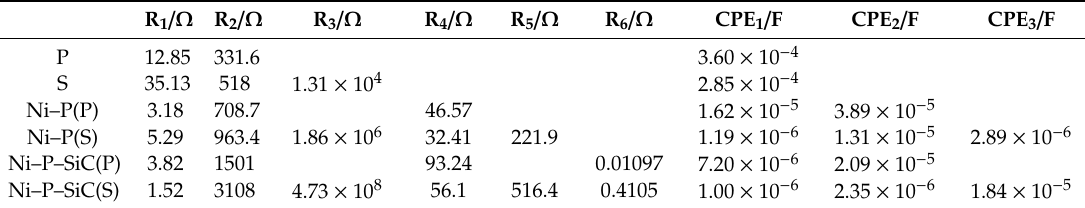
Figure 12. Equivalent circuit diagram of coatings prepared by scanning electrodeposition on 45 steel substrates with di ff erent pretreatment processes: ( a ) polishing, ( b ) sandblasting, ( c ) Ni–P(P), ( d ) Ni–P(S), ( e ) Ni–P–SiC(P), and ( f ) Ni–P–SiC(S). Table 5. Equivalent circuit diagram parameters of coatings prepared by scanning electrodeposition on 45 steel substrates with di ff erent pretreatment